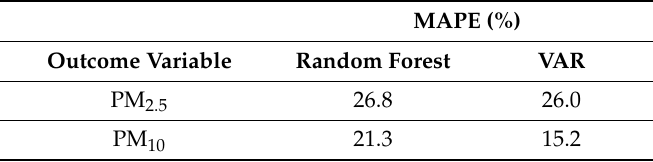
Table 3. Mean Absolute Percentage Error of the Random Forest and Vector Autoregressive models for both PM 2.5 and PM 10.